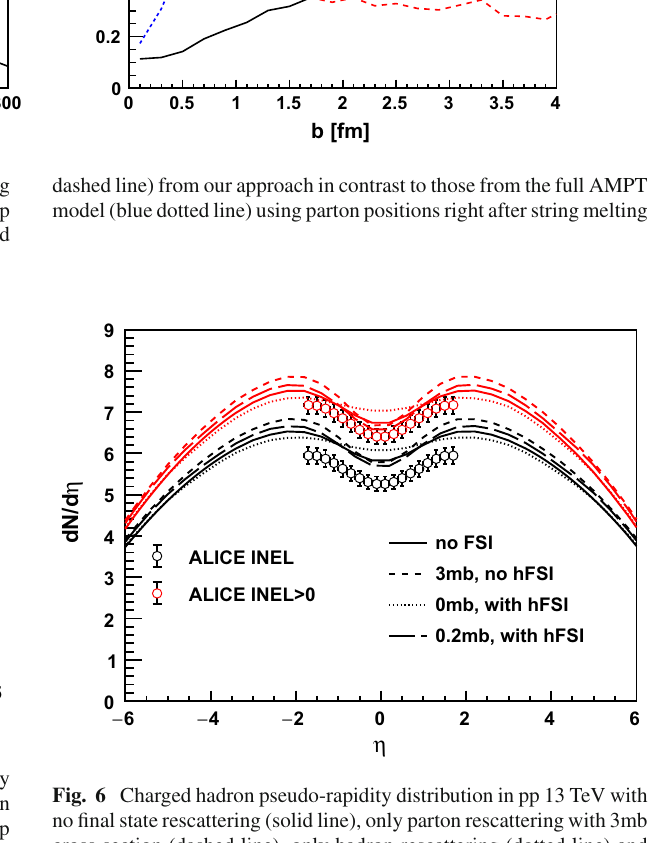
as a = 0 . 5, b = 0 . 9 GeV − 2 and the parton rescattering cross section set to 1.5